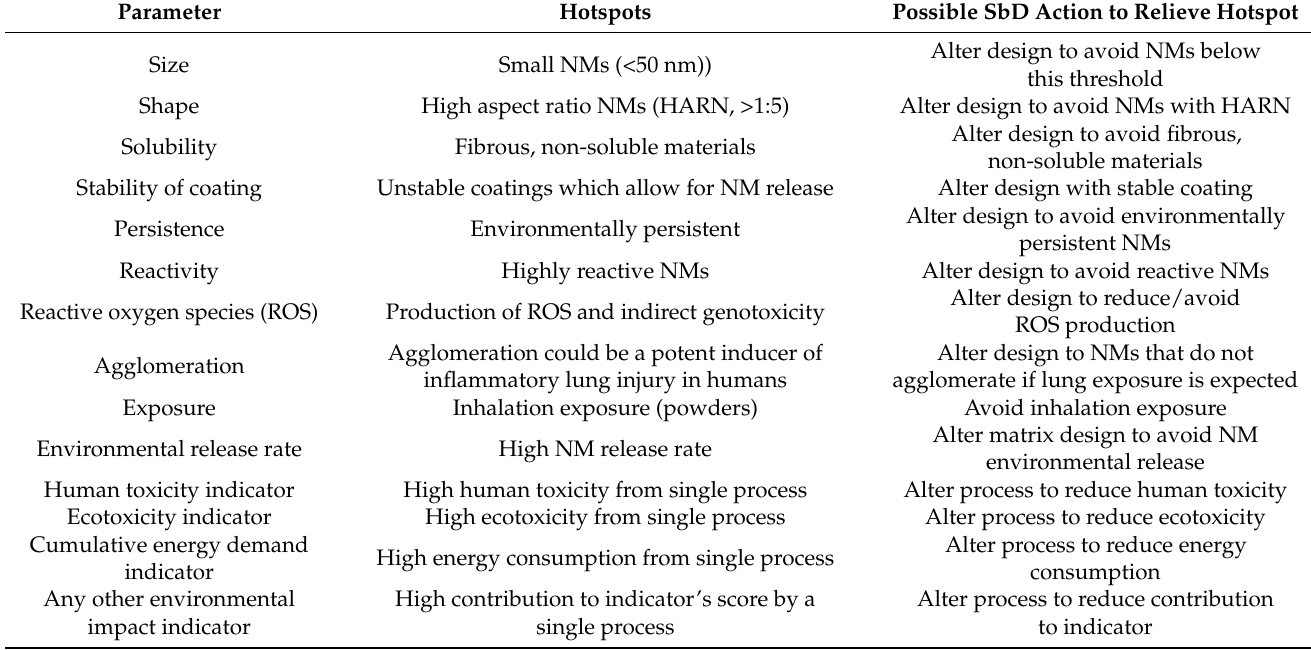
Table 6. Information needed for early toxicity analysis and LCA for SSbD